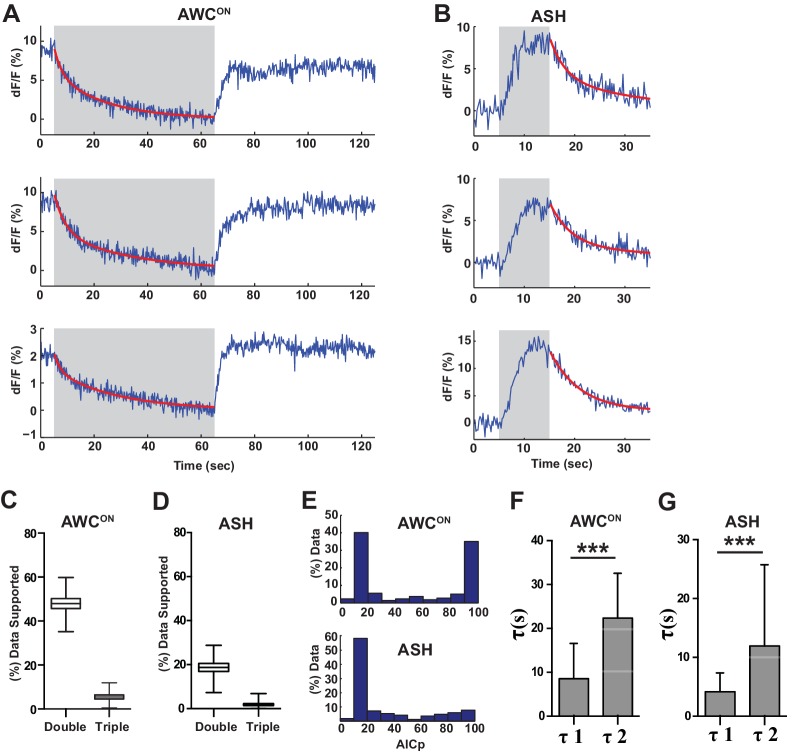
A proportion of VGLUT-pH recordings are consistent with multiple retrieval time constants.(A,B) Three individual examples of AWCON (A) or ASH (B) VGLUT-pH decays that fit a double exponential decay model with greater than 95% likelihood based on AICp (see Materials and methods). Gray areas mark stimulus periods. (C,D) Percent of VGLUT-pH data that fits a double or triple exponential model with greater than 50% likelihood (AICp >50%). Box and whisker plot created by 10,000 sampled bootstrap sampling. (E) Frequency histogram of AICp-based likelihood values for double exponential fits to VGLUT-pH data. An AICp value of >50 supports a double exponential fit with increasing likelihood; an AICp of less than 50 supports a single exponential with increasing likelihood. (C–E) AWCON data: n = 218 (76 animals, 2–3 trials each). ASH data: n = 168 (56 animals, 2–3 trials each). (F,G) Average decay constants from double exponential fits. Note similarity of two AWCON timescales to effects of plasticity in Figure 7F. Fits that minimized tau1 or tau2 to ~zero were excluded from the average. AWCON data: n = 211 (76 animals, 2–3 trials each). ASH data: n = 125 (56 animals, 2–3 trials each). Error bars = standard deviation. t-test p<0.0001. All ASH and AWCON data pooled from wild-type data used in this study. AWCON stimulus = 11.2 µM butanone (60 s). ASH stimulus = 500 mM NaCl (10 s).